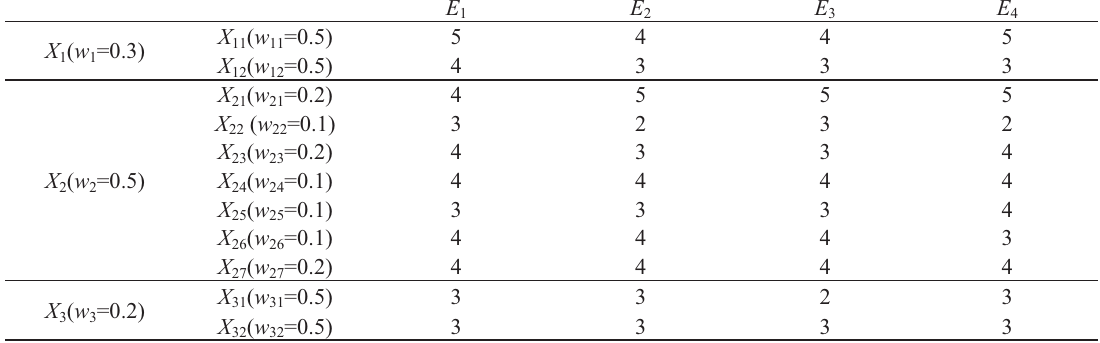
Table 6. The group decision matrix R 1 for South-line conformity project using NVs